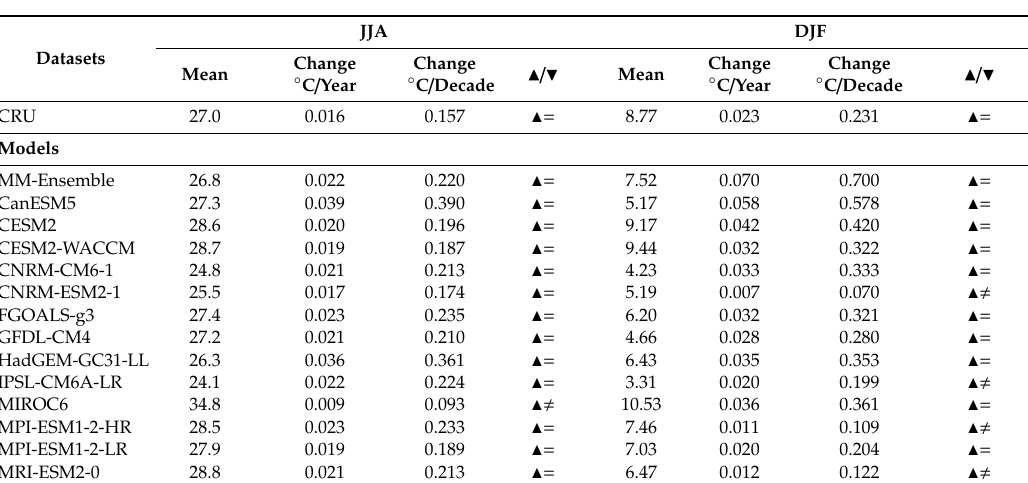
Table 2. Mean values, trend magnitude, and Sen’s slope for trend change ( ◦ C / decade) values for observed, MM-Ensemble, and models’ simulated mean temperature for 1970–2014 summer (JJA) and winter (DJF) season over